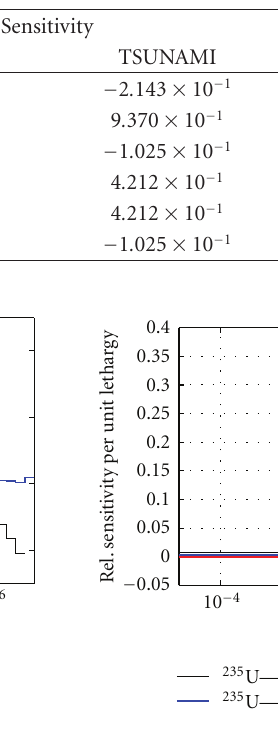
Figure 4: Multiplication factor sensitivity